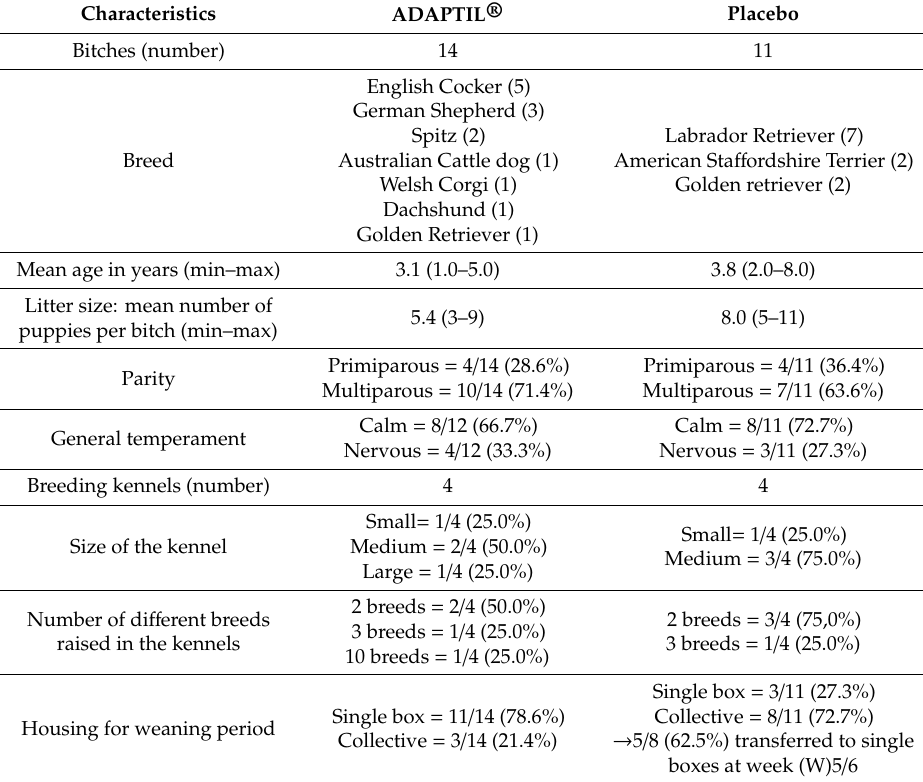
Table 2. Descriptive demographics on the selected bitches and